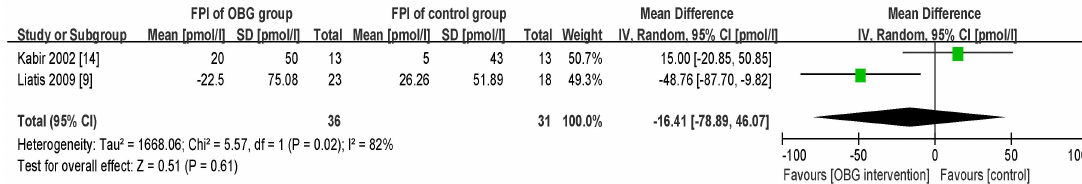
Figure 6. Forest plot for the effect of OBG intake on fasting plasma insulin (FPI) concentration. Data are expressed as mean differences in FPI concentration with 95% confidence intervals (CI). For Ma 2013 [15], FPI concentration is obtained at a dose of 2.5 g/day